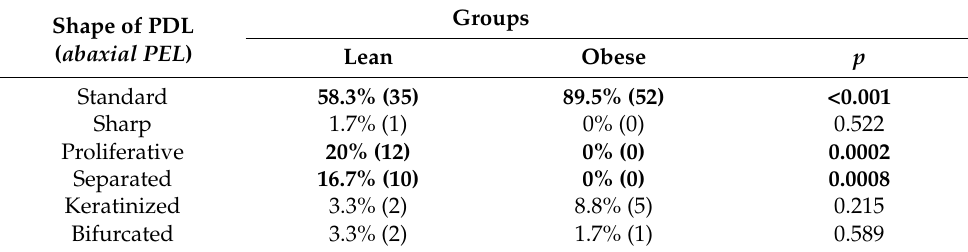
Table 2. Shapes of PDLs.